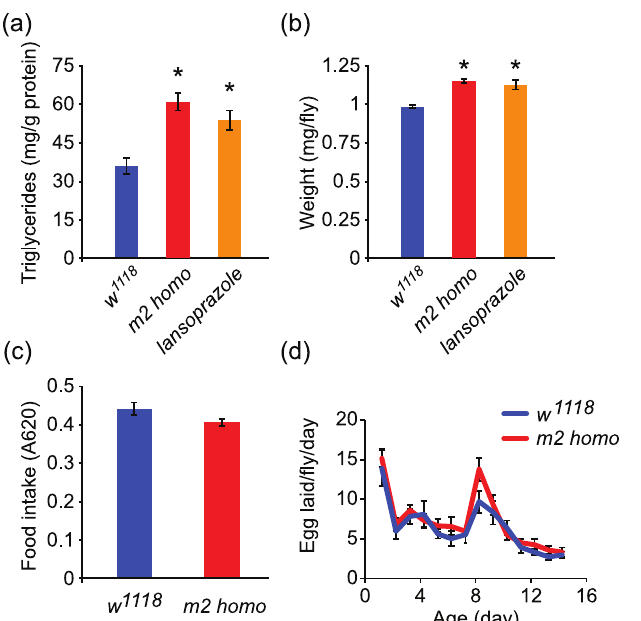
Fig 3. Midgut acid suppression induces an obese-like phenotype in flies. (a and b) m2 homozygous mutant flies (red) and lansoprazole-treated flies (orange) show increased triglyceride accumulation (a) and body weight (b) compared to control flies ( w 1118 , blue). (c and d) Food intake and female fecundity are not altered in m2 homozygous mutant flies (red) compared to control flies ( w 1118 , blue). Data were collected from 8 – 10 replicates for each group. Each replicate contained 10 flies for triglyceride (a), body weight (b) and feeding assays (c), and 3 mated pairs for female fecundity measurements (d). * , P < 0.05, compared to the control group.